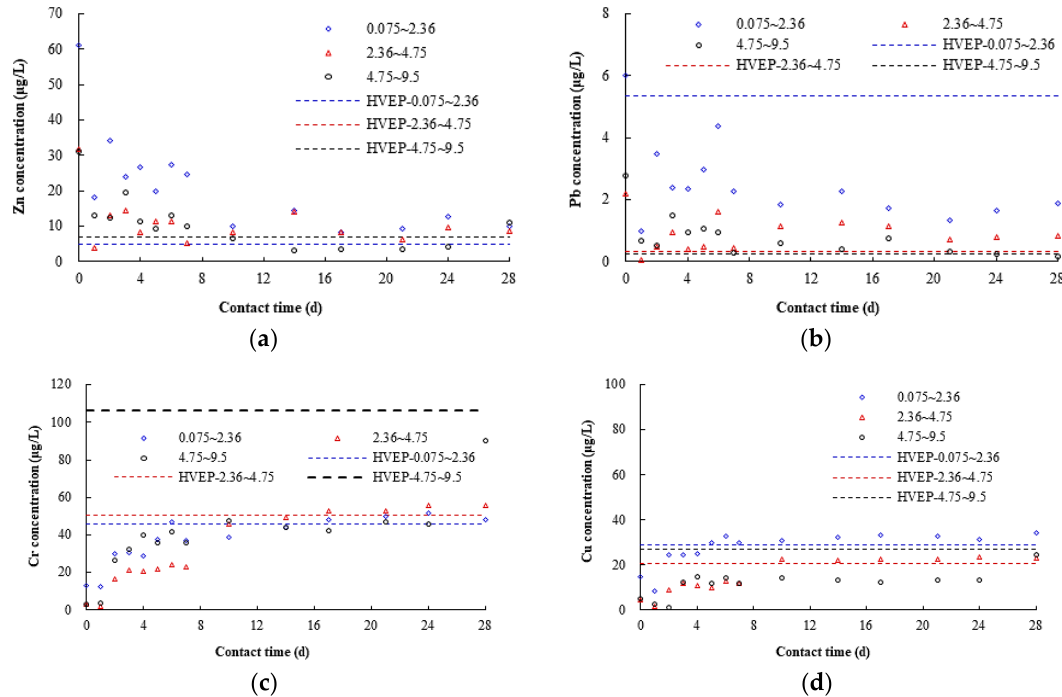
Figure 8. Leaching concentrations of heavy metals from MSWI-BAA by both the HVEP test and simulated leaching experiment: ( a ) Zn; ( b ) Pb; ( c ) Cr and ( d ) Cu.